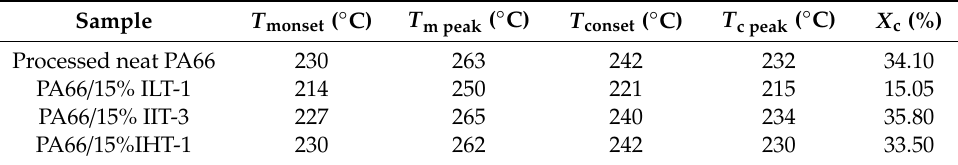
Table 1. DSC thermal properties for the studied systems.